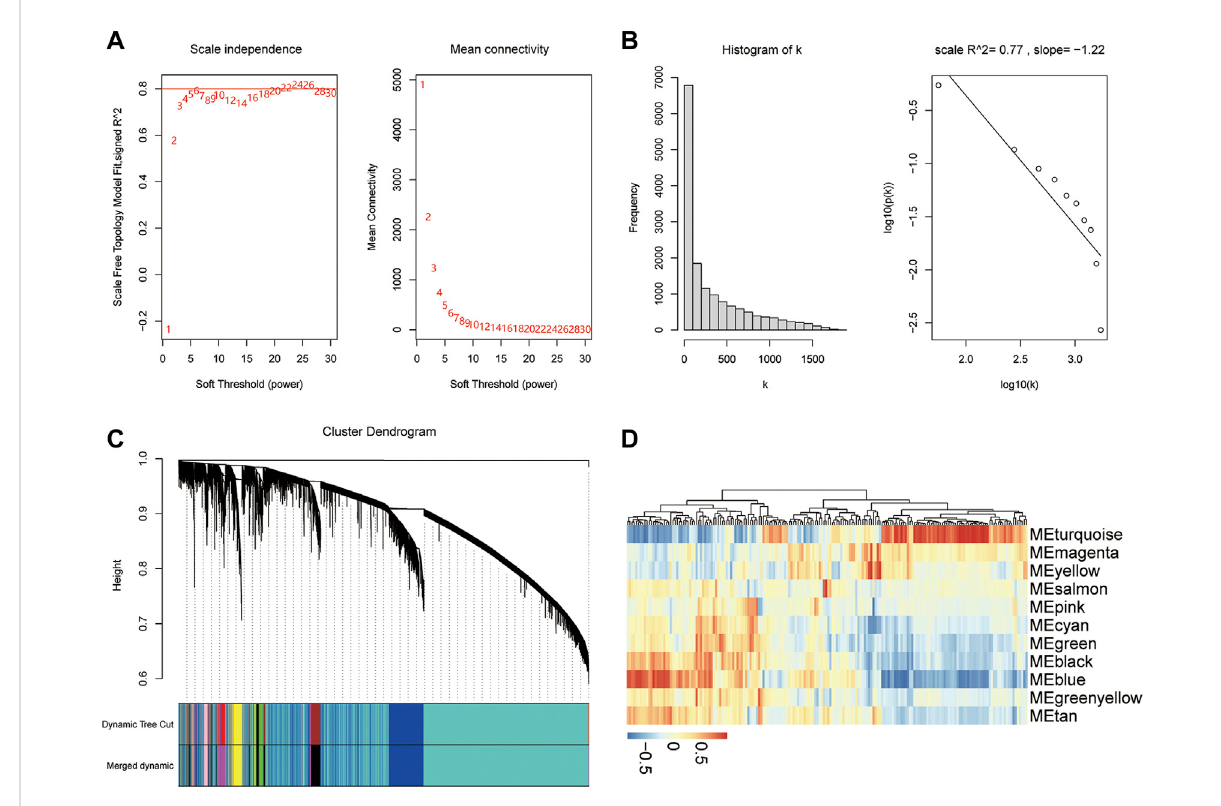
FIGURE 8 WGCNA. (A) Analysisofthescale-freeindexandthemeanconnectivityforvarioussoft-thresholdpowers. (B) Checkingthescale-freetopology when β = 6. (C) Dendrogram of the pyroptosis-related genes. The color band shows the results obtained from the automatic single-block analysis. (D) Heatmap of the correlations between the modules and traits of